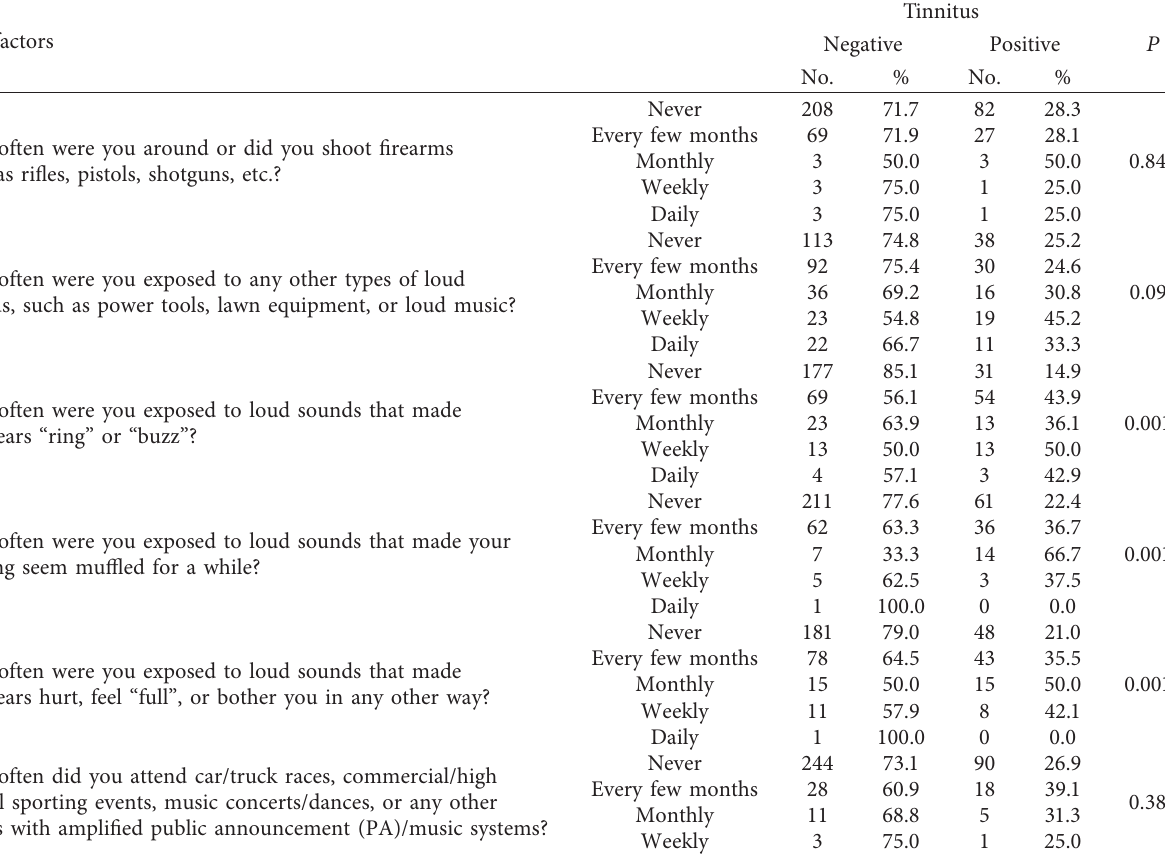
Table 3: Distribution of students’ tinnitus status according to exposure to different risk